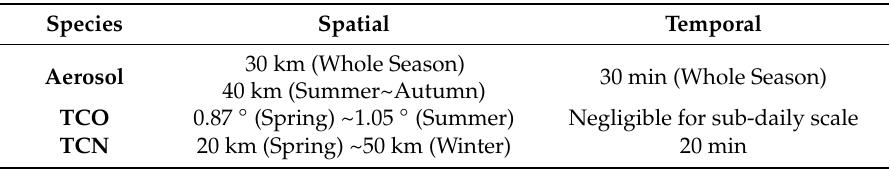
Table 5. Strategy of the validation plans for the GEMS scientific products in East